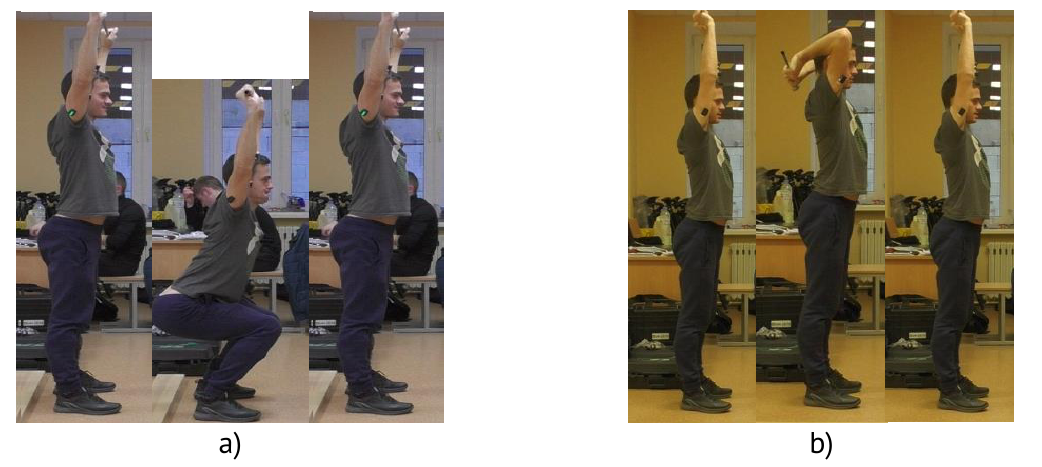
Figure 1 . Test symmetrical acyclic motions: a – squatting with raised arms; b – bending in the ulnar joints. 2. Bending in the ulnar joints (figure 1